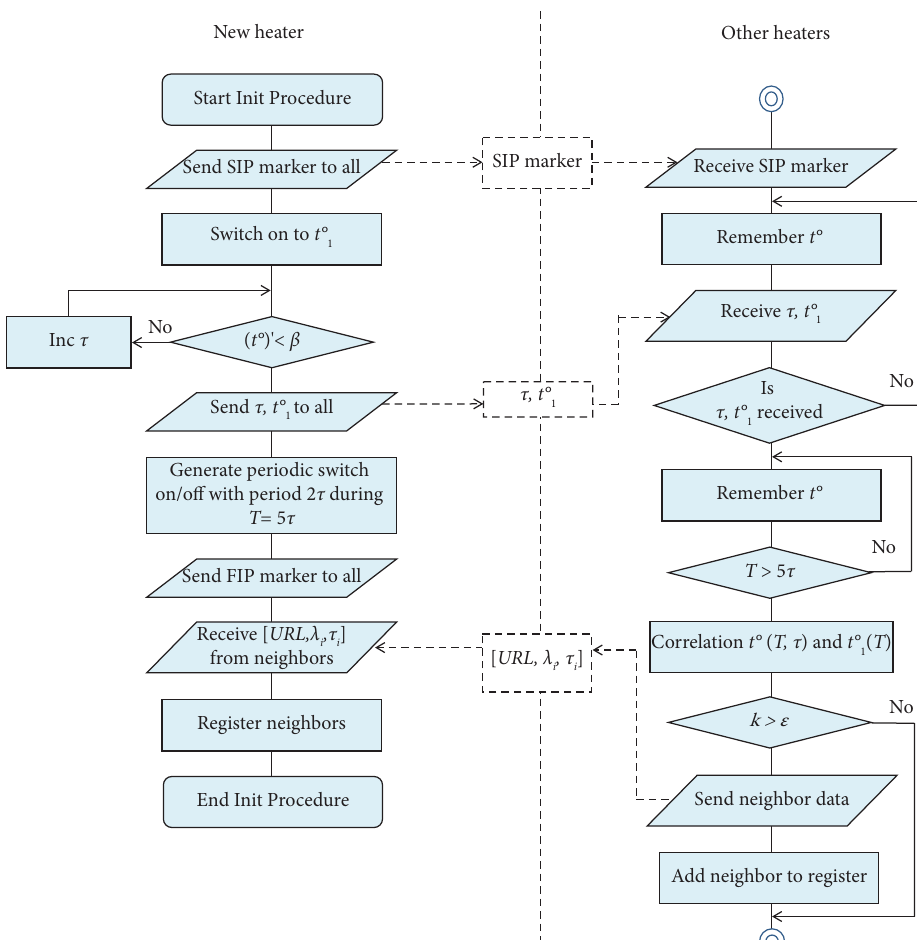
Figure 4: Algorithm for determining the set of MSH based on the procedure of impact testing.